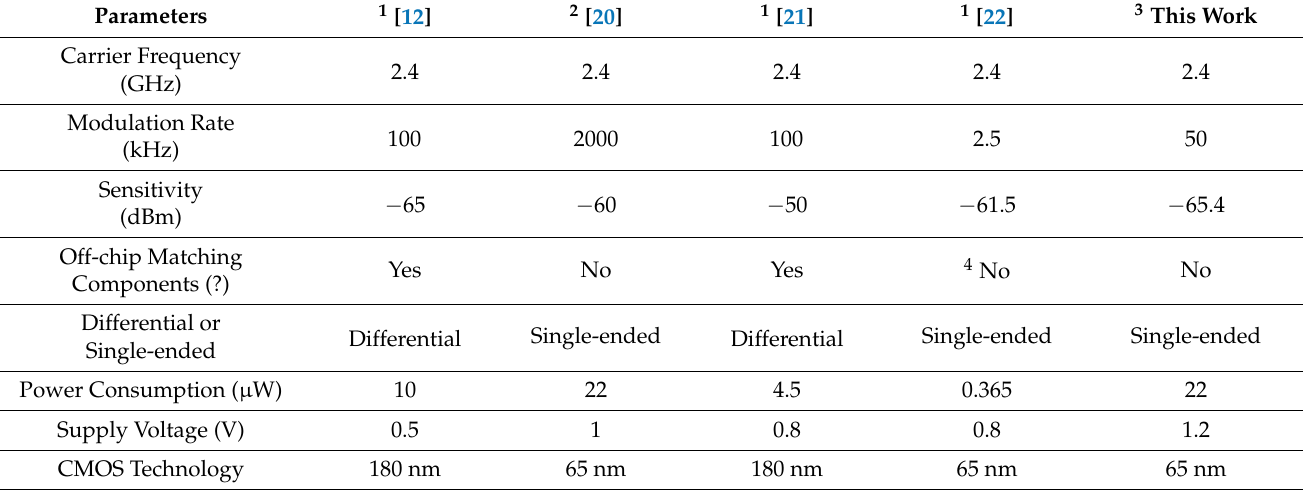
Table 2. Performance summary and comparison with the traditional 2.4 GHz WuRx